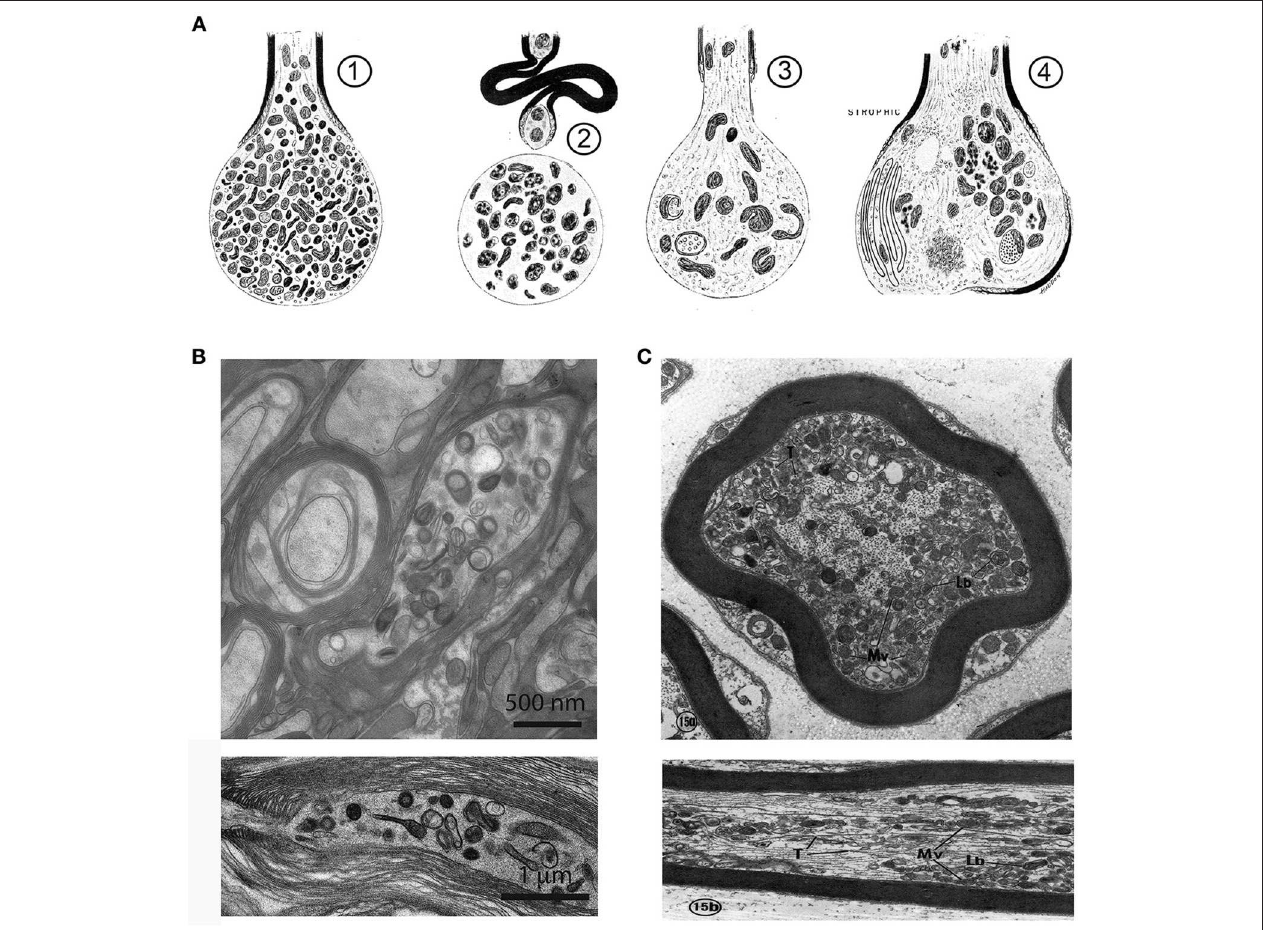
FIGURE 2 | Axonal organelle accumulations after traumatic injury or interruption of axonal transport. (A) Early description of axonal pathology after traumatic spinal cord injury in the rat, based on electron microscopic observations. (1) After transection the axonal stump swells and accumulates mitochondria, vesicles and dense bodies. (2) In a degenerative stage the organelles disintegrate. (3) A regenerative axon is characterized by a growth cone with multiple organelles. (4) A dystrophic axonal enlargement, caused by demyelinating disease or vitamin E deficiency is characterized by abundant filaments and organelles such as mitochondria, dense bodies, layered membrane loops, and cytoplasmic dense material. Reproduced from Lampert (1967), with permission. (B) Electron micrographs of focal swellings and organelle accumulations in CNS axons (upper: cross section, lower: longitudinal section), here derived from white matter of adult Plp1 null mice . Note that organelle accumulations are predominantly located in the juxtaparanodal region (lower). (C) Electron micrographs of axonal changes in the PNS after interruption of axonal transport in the mouse saphenous nerve by cooling. At the distal side of the transport block, retrogradely transported axonal elements accumulate along the internode. These are, among others, multivesicular bodies (Mv), lamellated bodies (Lb) which intermingle with microtubules (T), and neurofilaments (Upper: cross section, Lower: longitudinal section). Reproduced from Tsukita and Ishikawa (1980) with